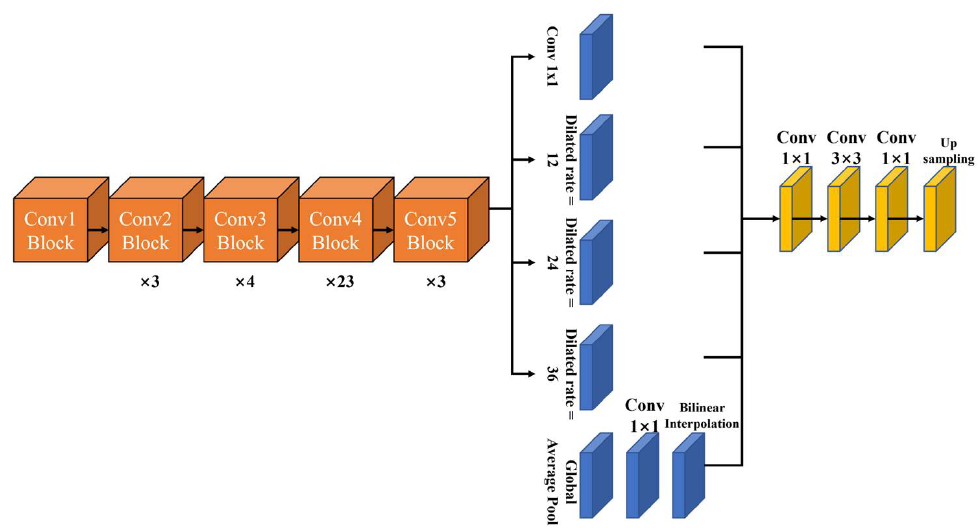
Figure 7. Structure of DeepLabv3 model.